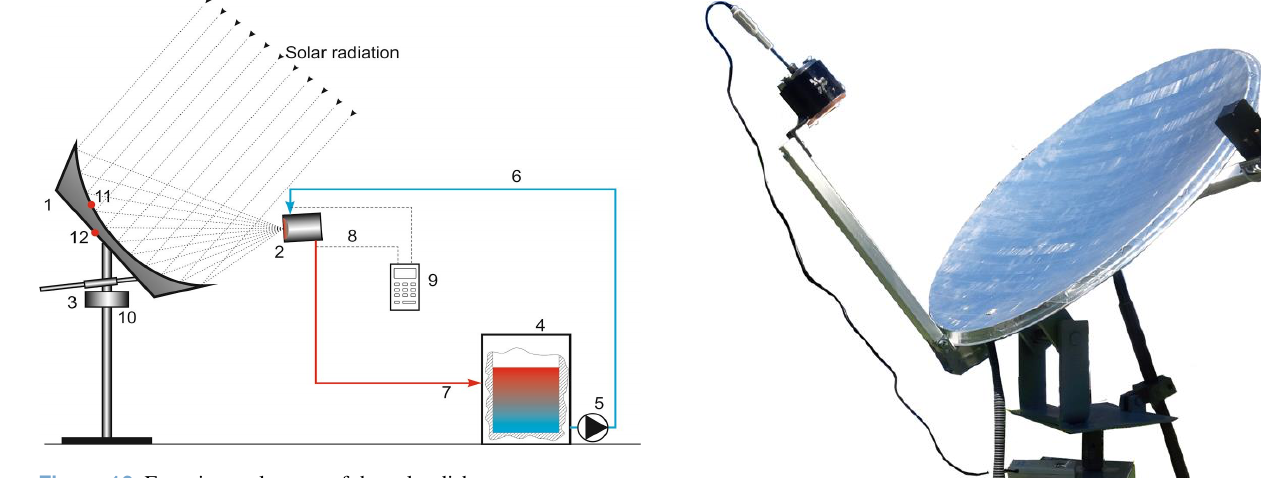
Figure 16. Experimental set up of the solar dish concentrator.